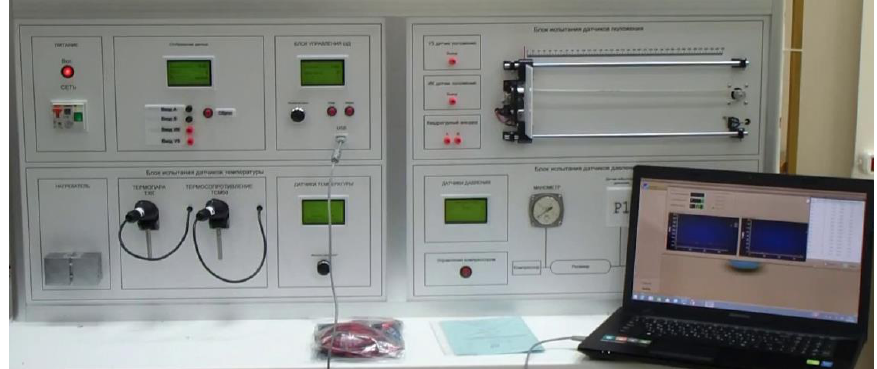
Figure 4. Unit for collecting information and monitoring air parameters in the wind